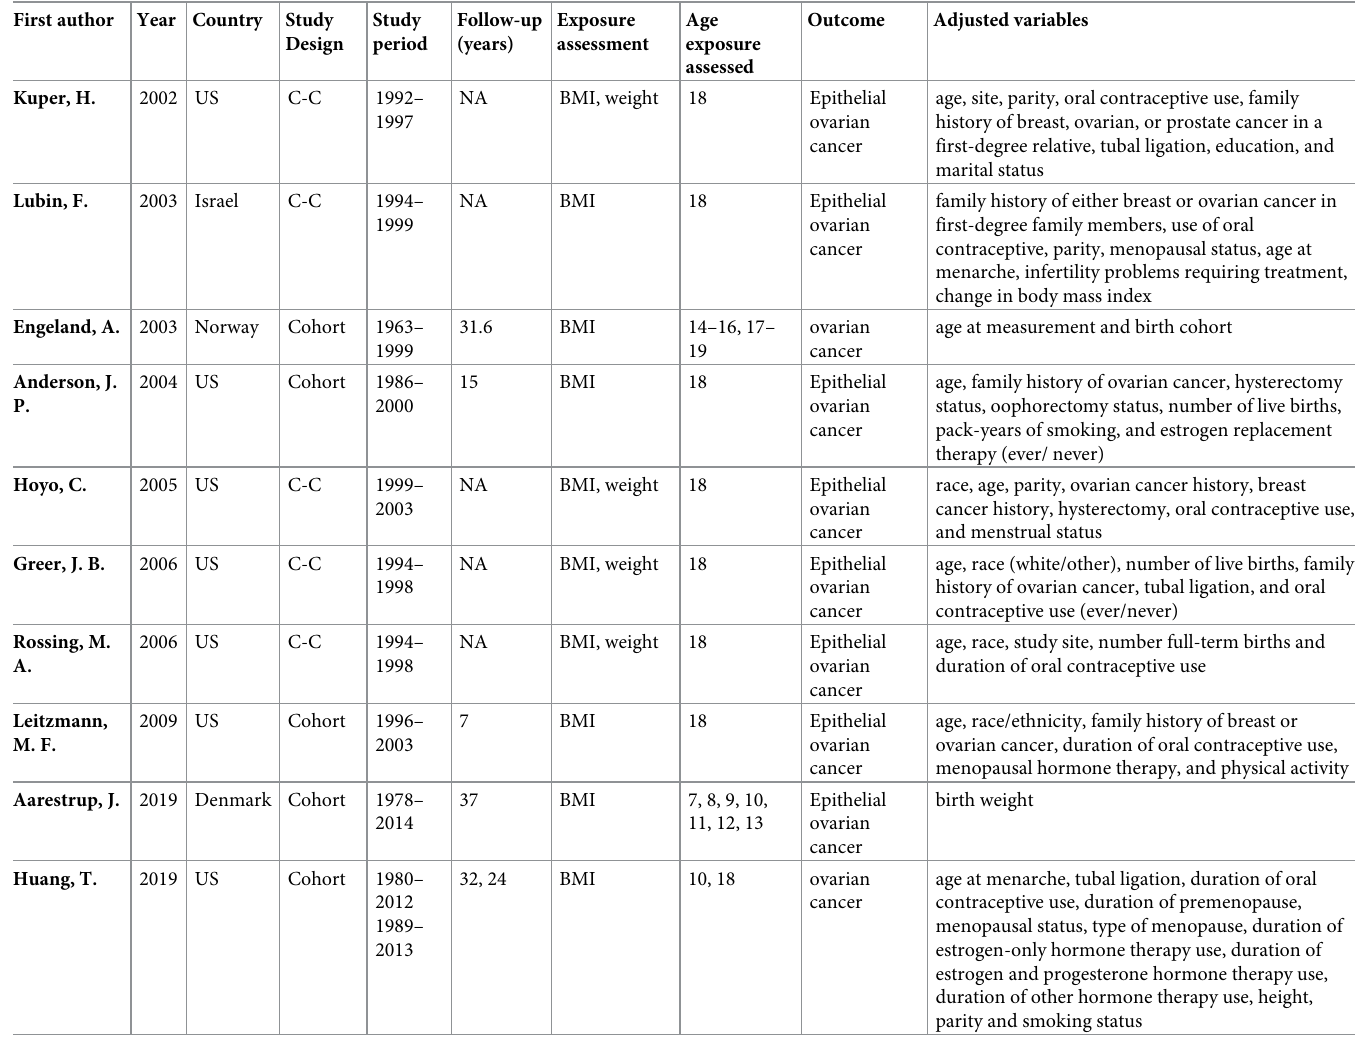
Table 1. Descriptive characteristics of studies on the association of obesity in children and adolescents with ovarian